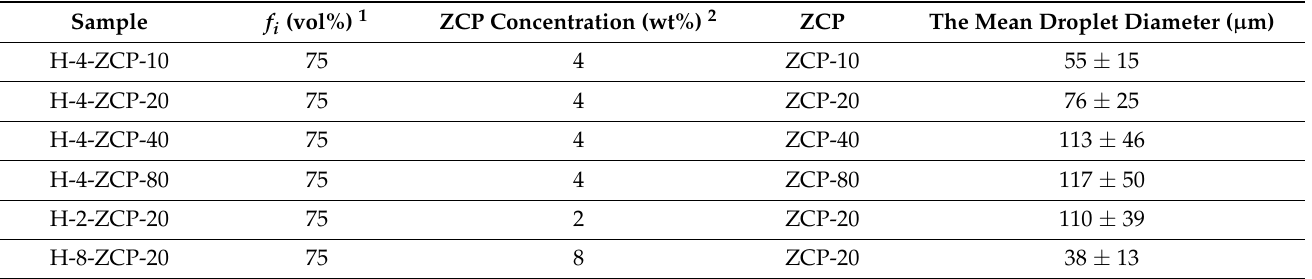
Figure 4. LSCM images of Pickering HIPEs with different ZCP kinds and concentrations: ( a ) H-4- ZCP-10; ( b ) H-4-ZCP-20; ( c ) H-4-ZCP-40; ( d ) H-4-ZCP-80; ( e ) H-2-ZCP-20; and ( f ) H-8-ZCP-20. The aqueous phase was dyed with Rhodamine B, and the emission wavelength was 561 nm. Table 2. Composition of o/w emulsions stabilized by